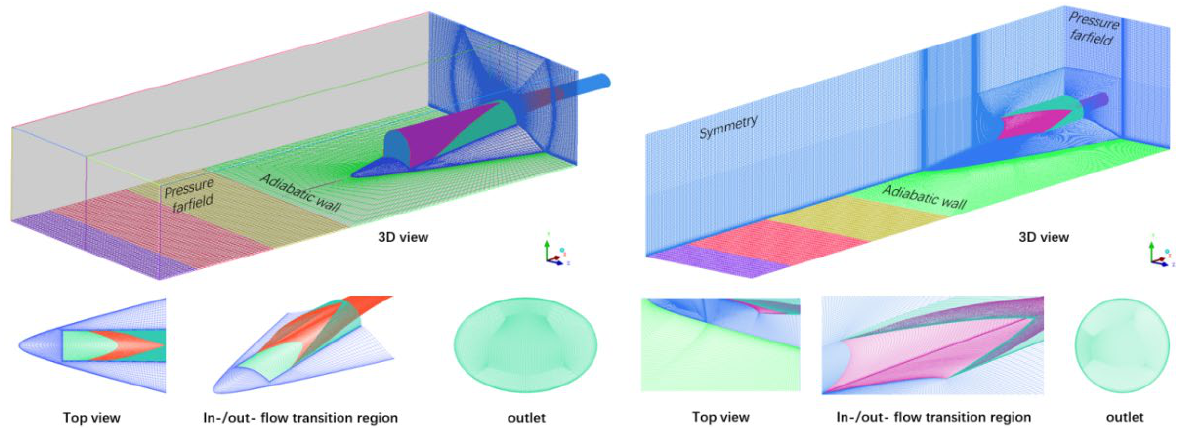
Figure 3. Three-dimensional-structured meshes for bump inlets ( left : Form 1; right : Form 2). Table 2. Inflow conditions for numerical